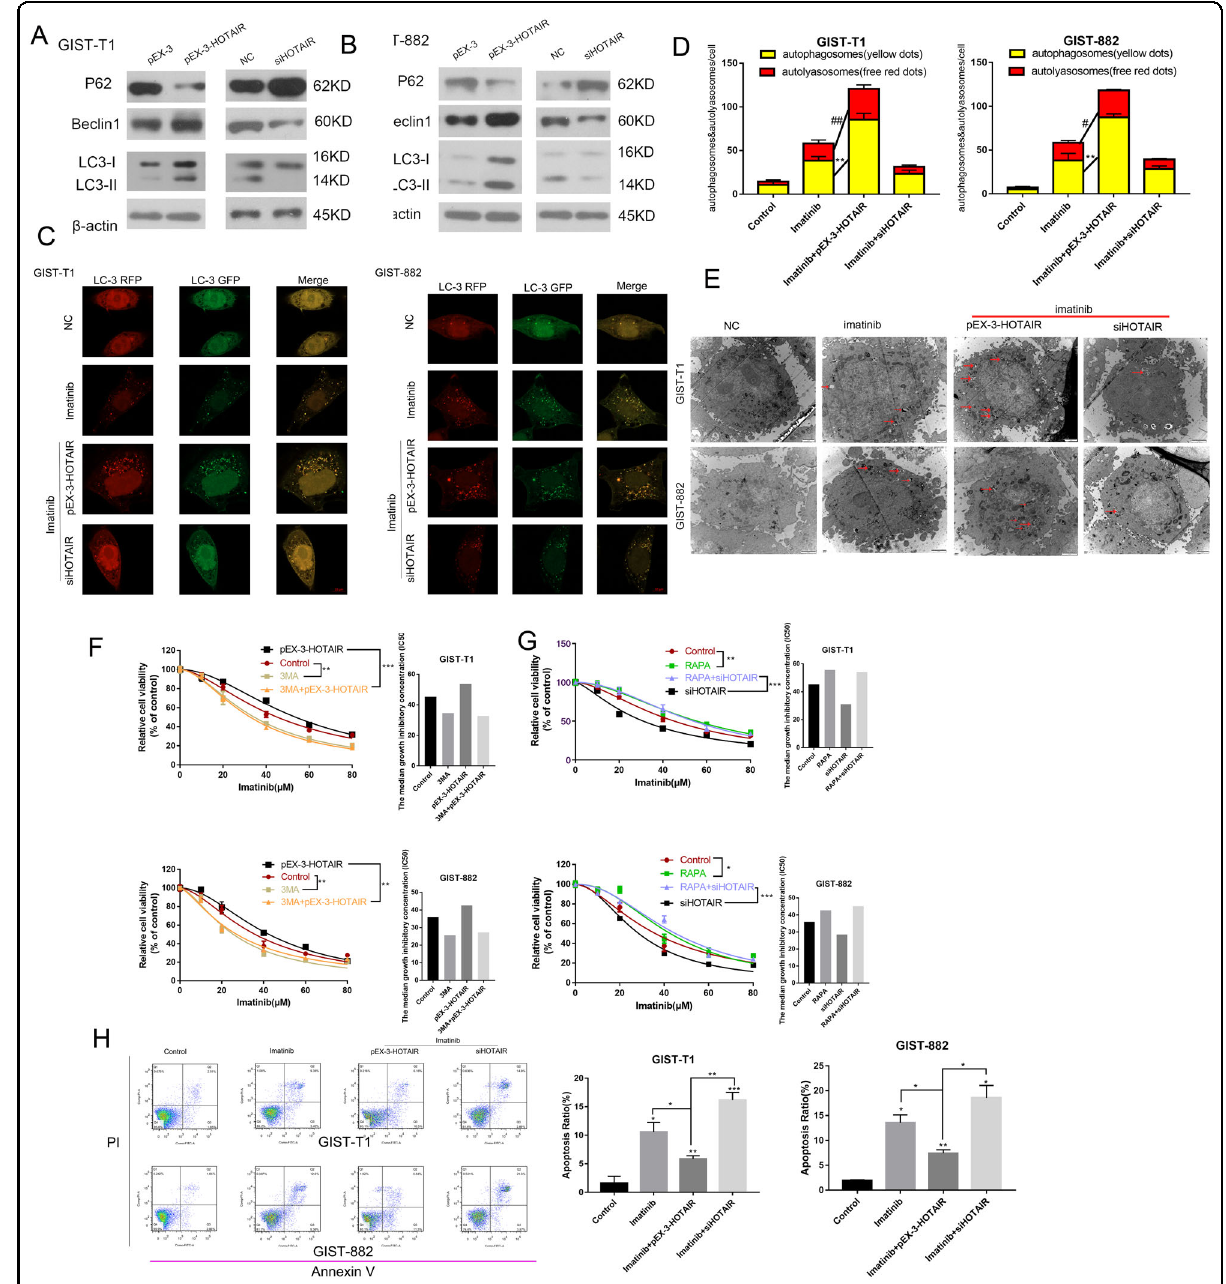
Fig. 2 HOTAIR regulates cell autophagy. A , B Western blotting was performed to detect the levels of autophagy-related proteins in GIST cells after transfection. C , D Confocal microscopy: red dots indicate autolysosomes. # P < 0.05, ## P < 0.01 vs. imatinib: yellow dots indicate autophagosomes. * P < 0.05, ** P < 0.01 vs. imatinib. E Autophagosomes were observed by electron microscopy. F CCK-8 assays were performed after GIST cells were treated in four different ways (negative control, 3-MA, pEX-3-HOTAIR, and 3-MA plus pEX-3-HOTAIR). ** P < 0.01, *** P < 0.001 vs. control or pEX-3-HOTAIR. G CCK-8 assays were performed after GIST cells were treated in four different ways (negative control, RAPA, siHOTAIR, RAPA plus siHOTAIR). * P < 0.05, ** P < 0.01, *** P < 0.001 vs. control or siHOTAIR. H Flow cytometry analysis to determine the effect of HOTAIR in rescuing GIST cells from apoptosis. * P < 0.05, ** P < 0.01, *** P < 0.001 vs. control or Imatinib +